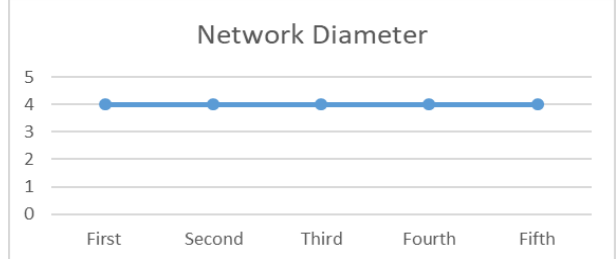
Figure 14. Network Diameter for network graph after grouping